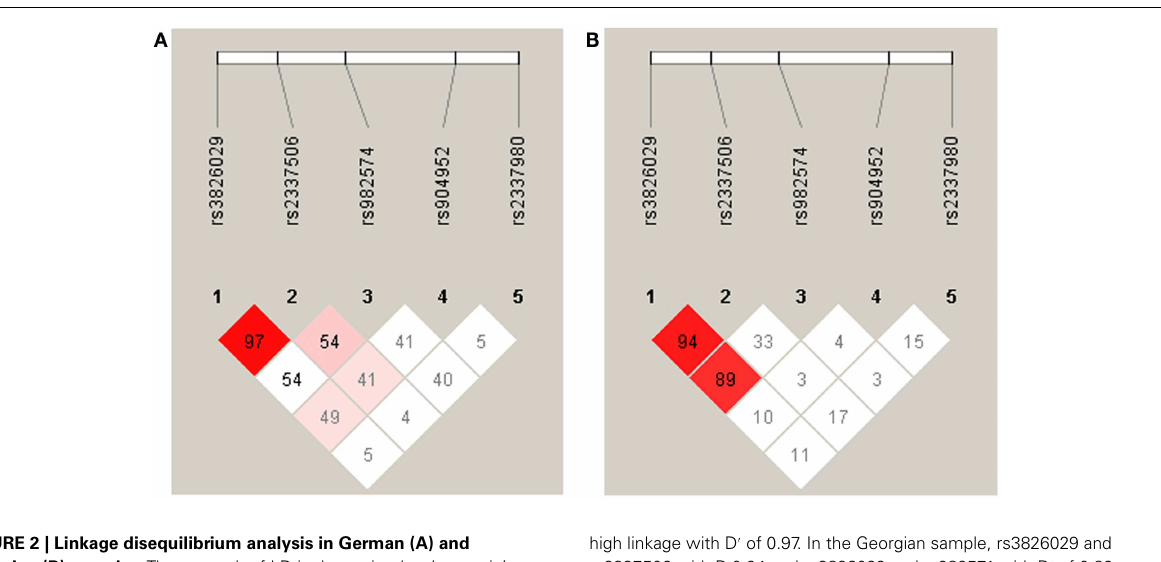
high linkage with D (cid:48) of 0.97. In the Georgian sample, rs3826029 and rs2337506 with D (cid:48) 0.94 and rs3826029 and rs982574 with D (cid:48) of 0.89 were in